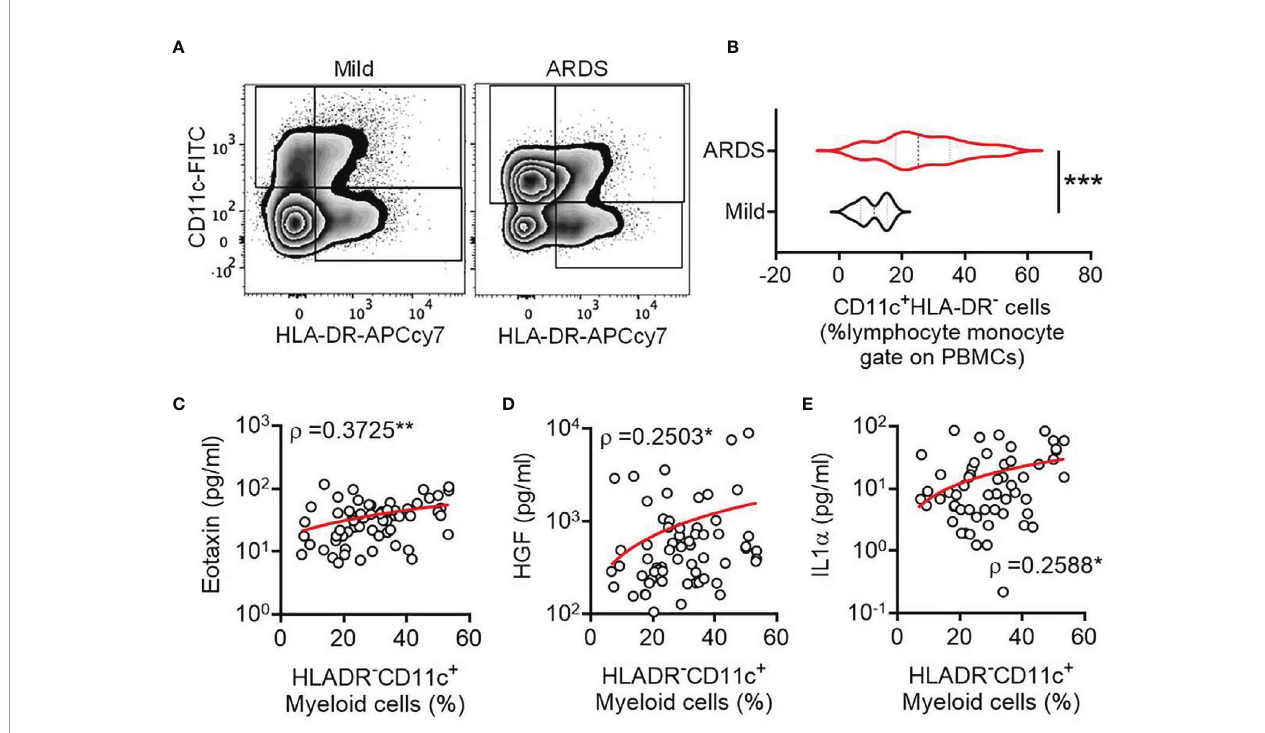
FIGURE 1 | Expansion of circulating CD11c + HLA-DR - myeloid cell subset in severe COVID-19. (A) Representative fl ow cytometry plots for gating of circulating CD11c + HLA-DR - myeloid cells from COVID-19 patients with either mild disease or ARDS. (B) Violin plots showing the frequency of circulating CD11c + HLA-DR - myeloid cells compared between COVID-19 patients with either mild disease or ARDS. The Mann Whitney test was performed, ***p < 0.0005. (C – E) Correlation between the frequency of circulating CD11c + HLA-DR - myeloid cells and plasma level of the cytokines Eotaxin (C) , HGF (D) , and IL-1 a (E) is plotted. Spearman r values are shown, **p < 0.005, *p <